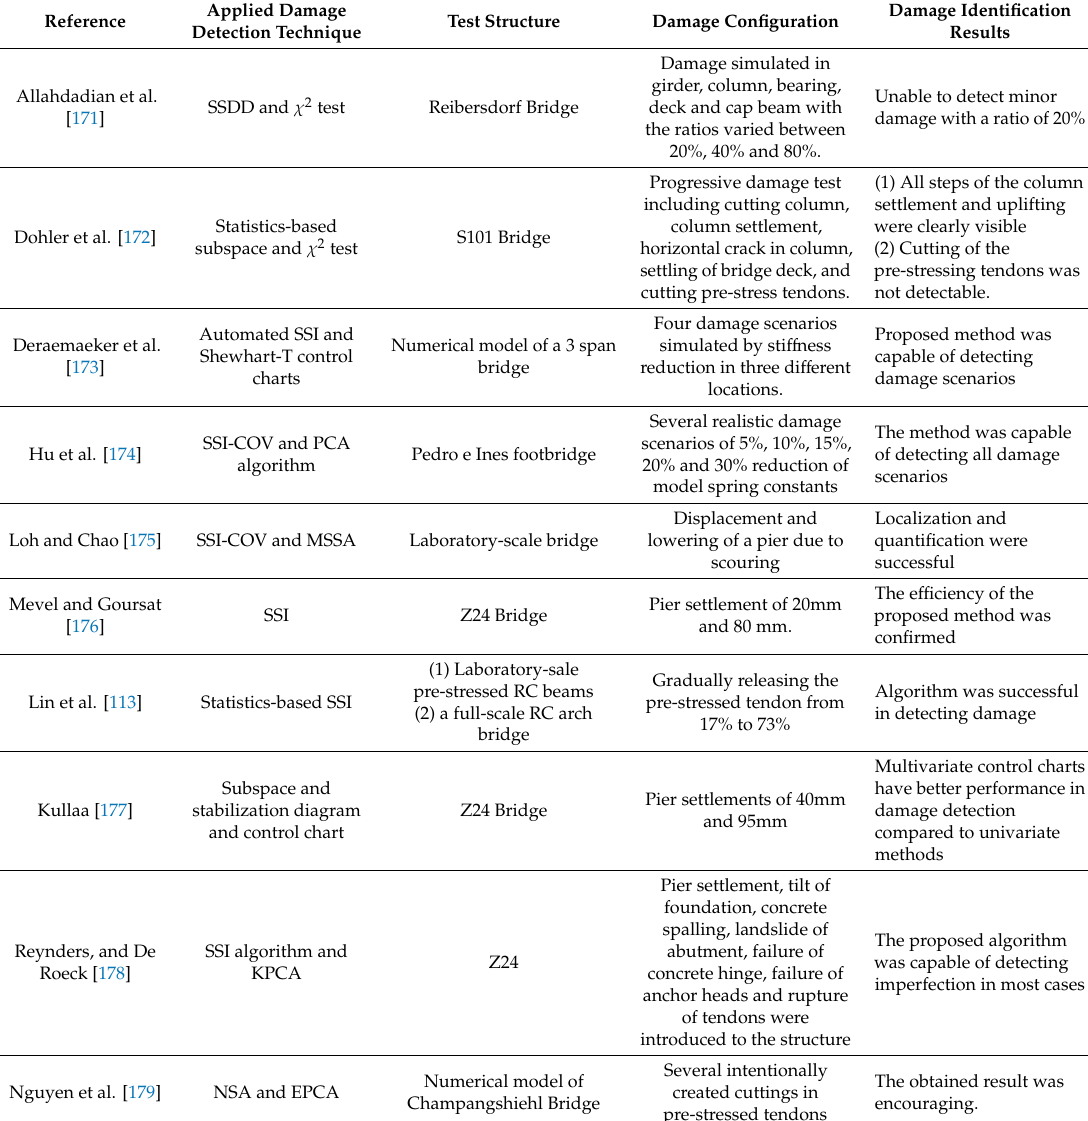
Table 9. Application of SSI algorithms for damage detection of bridges and other